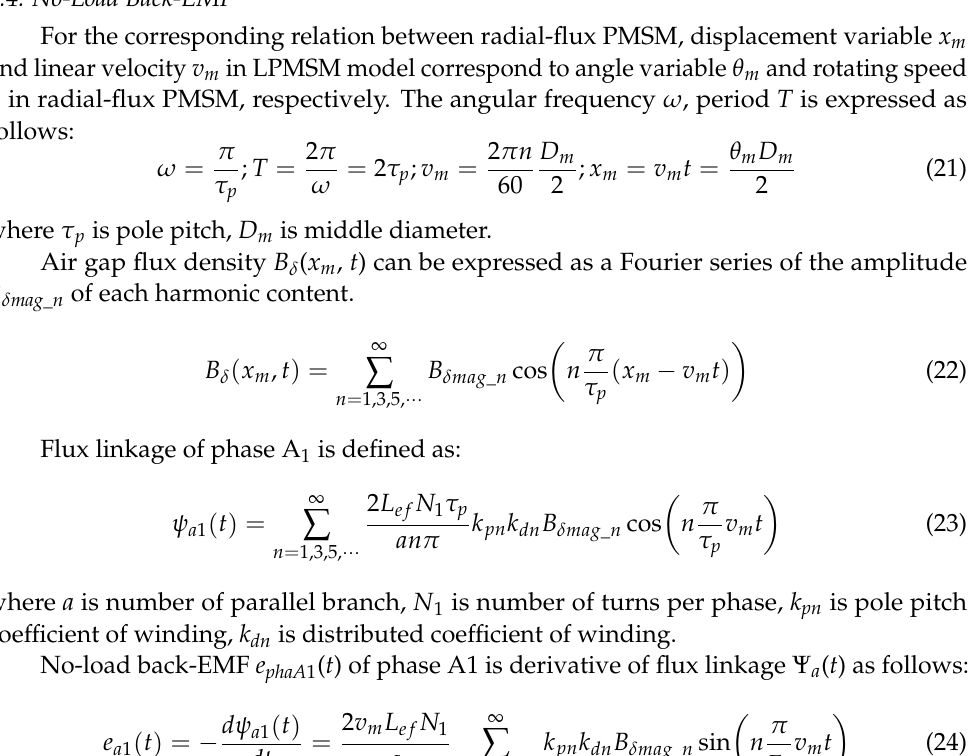
Figure 20. Measurement of flux density of air gap, ( a ) drive end side, ( b ) non-drive end side.